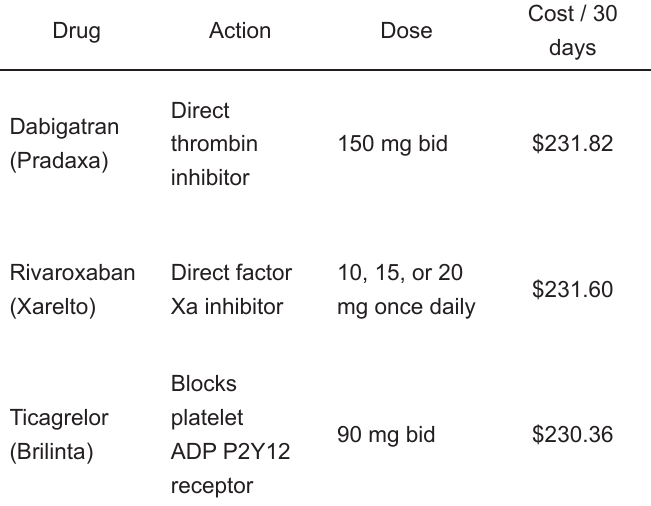
Table 5. Some new anticoagulant /antiplatelet